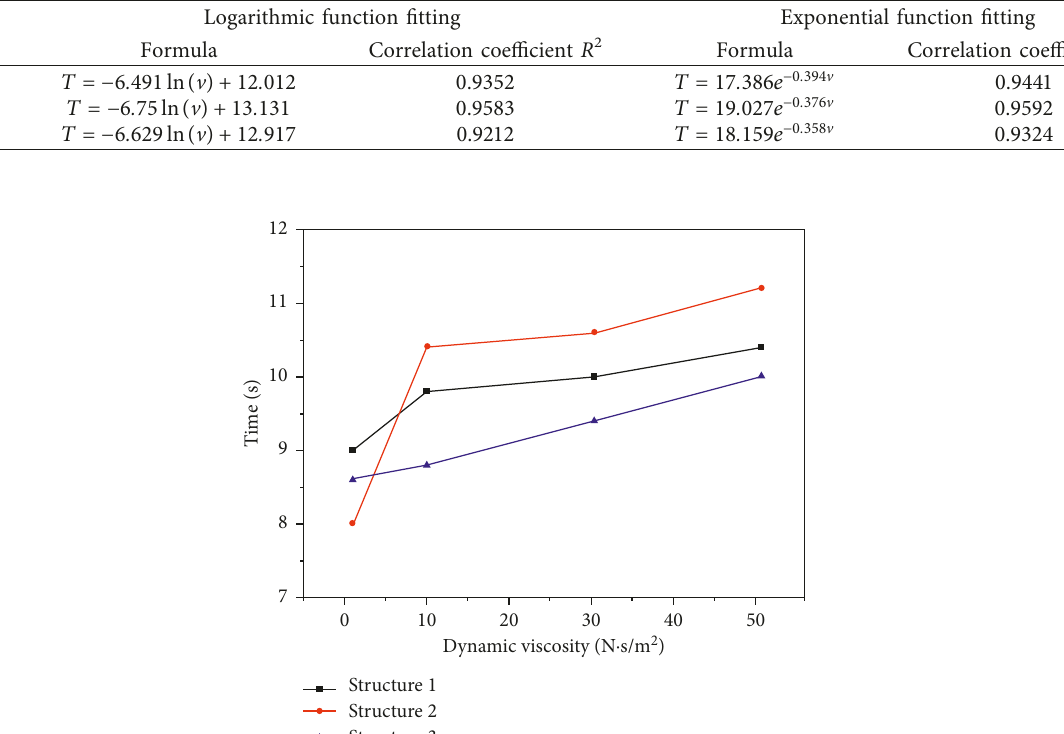
Table 1: Fitting function of seepage time and initial water velocity.